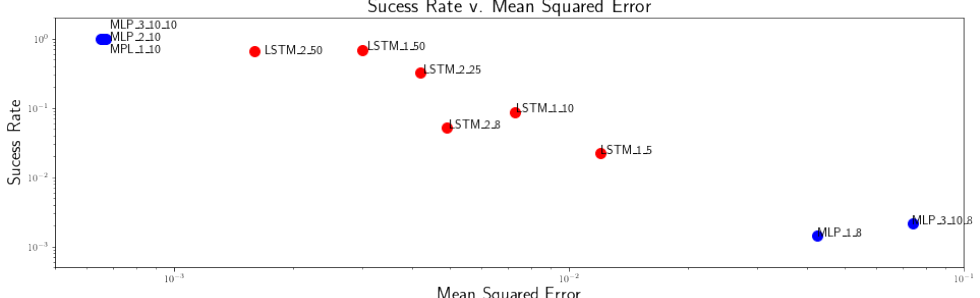
Figure 10. The success rate of the predictions of the different networks in a subset of 2000 sequences from the training data, and their Mean Squared Errors in the validation